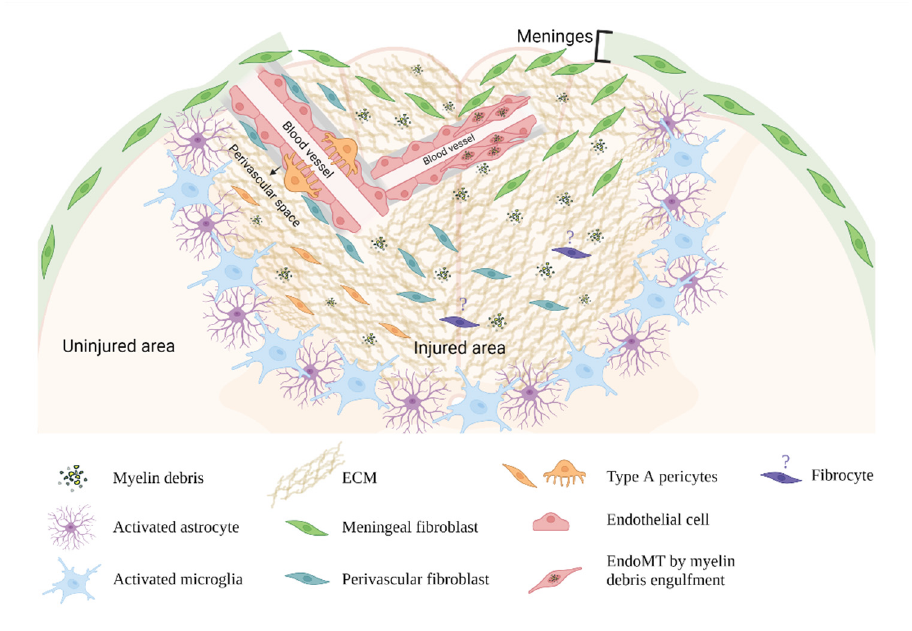
Figure 1. Origins of fibroblasts in the CNS fibrotic scar. This figure summarizes the origins of fibroblasts that contribute to the deposition of ECM proteins and the formation of the fibrotic scar in the CNS. This image was created with BioRender.com (accessed on 29 July